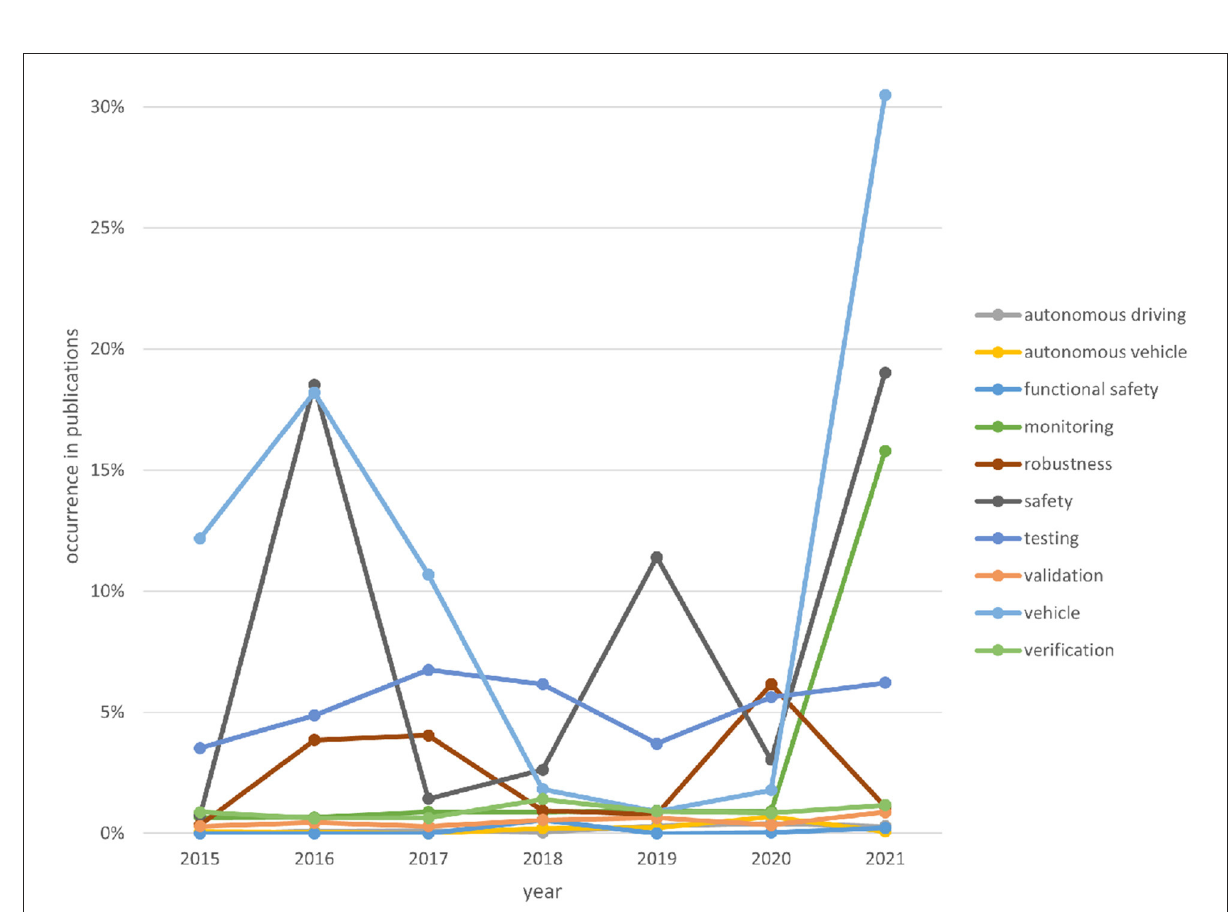
FIGURE5 Occurrences of keywords in